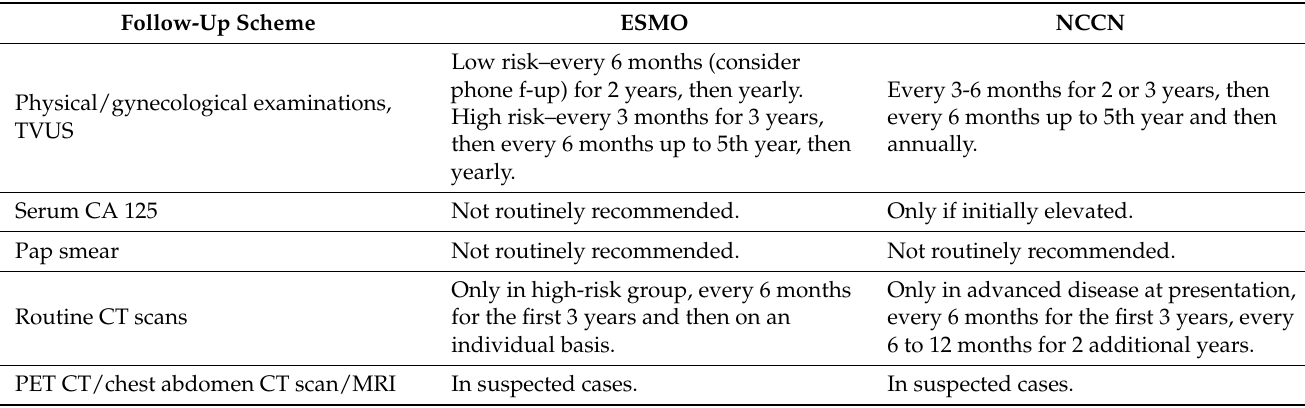
Table 4. Follow-up